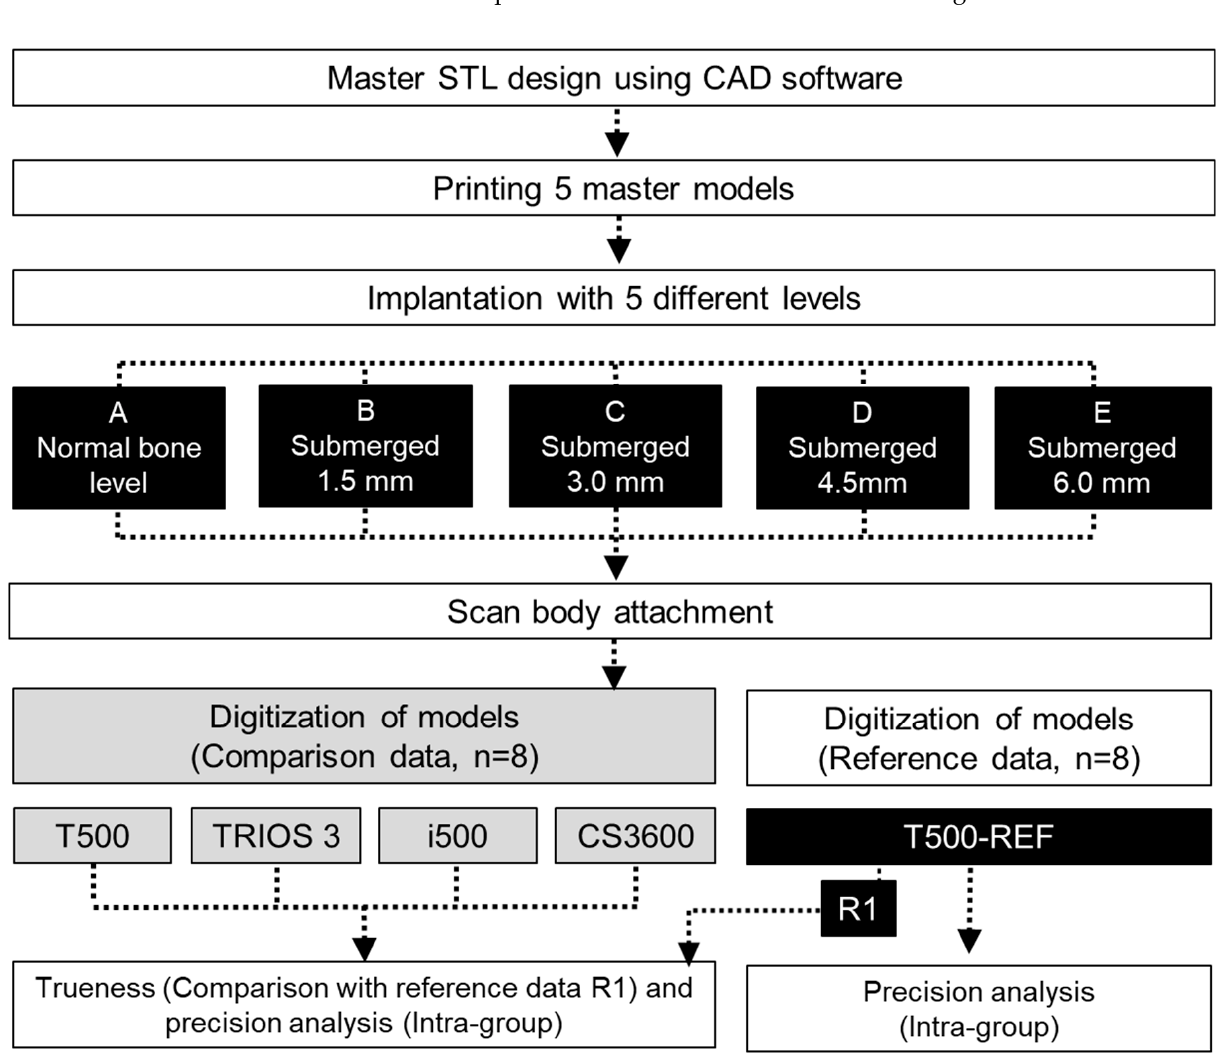
Figure 1. Overall experimental workflow of this study, showing the scanning procedure and the scanners used. A maxillary model (Dentiform, Nissin Dental Products, Kyoto, Japan) was scanned using a tabletop scanner (T500, Medit, Seoul, Korea), and the created study model was exported as files in Standard Tessellation Language (STL) format. The STL was imported into dental CAD software (Exocad DentalCAD, Exocad, Darmstadt, Germany). The lateral incisor, first premolar, and first molar of the model were removed to create a modified model in the form of an edentulous ridge. Five maxillary master models were printed using a 3D printer (Form 2, Formlabs, Somerville, MA, USA) and light-cured resin (standard gray resin, Formlabs). Screw-typed bone-level implants (10 mm long and diameter of 4.1 mm; Straumann, Basel, Switzerland) were placed where teeth were removed at different levels: Normal bone level, submerged 1.5 mm, submerged 3.0 mm, submerged 4.5 mm, and submerged 6.0 mm. The direction of the internal antirotation structure of the fixture was unified to keep the direction of the ISB the same as that of the implant in the buccal direction (Figures 2 and